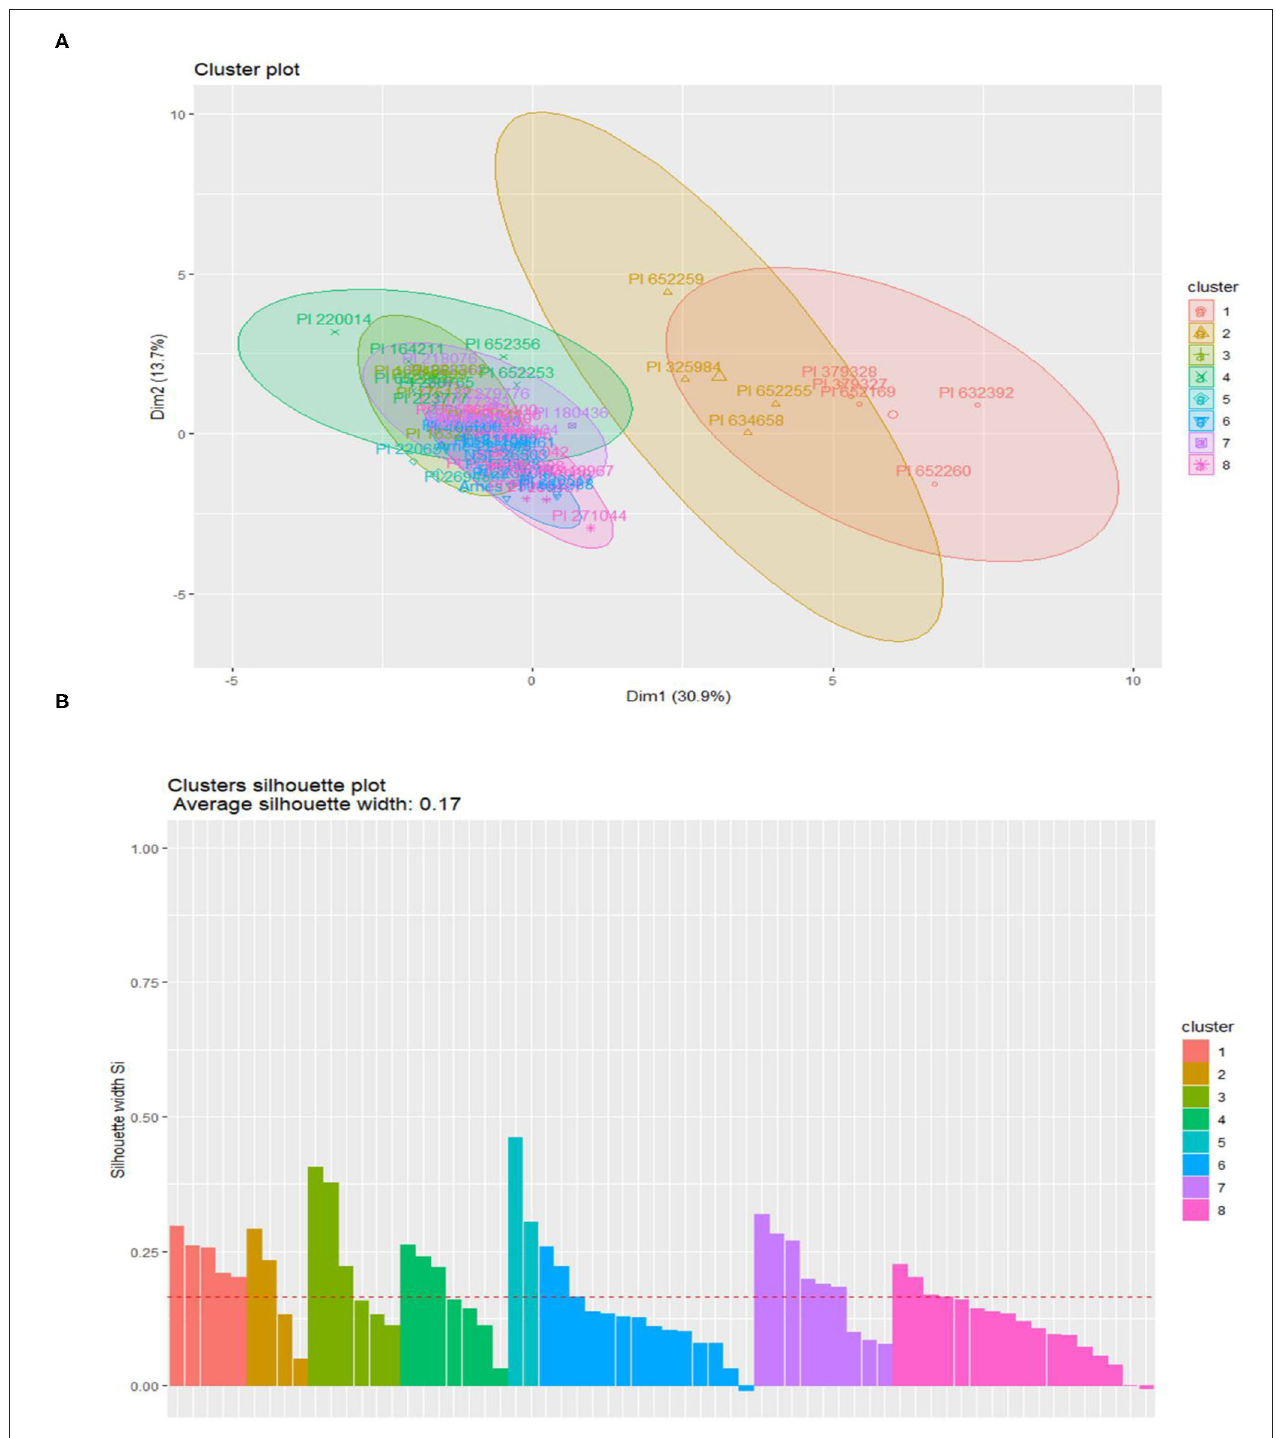
FIGURE 5 | (A) K-means clustering of 64 carrot genotypes grouped into 8 k-clusters represented by different colors based upon nutritional profiling. (B) Validation of k-means clusters by Silhouette plots. The outliers are in blue and pink color.